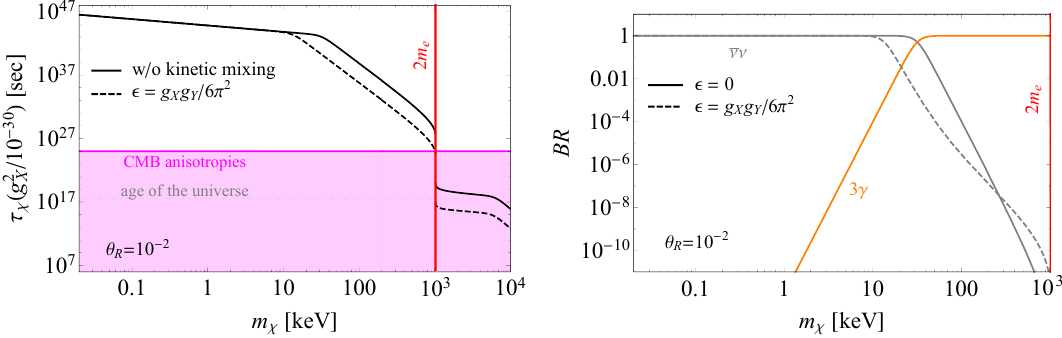
Figure 1 . Lifetime (left) and BRs (right) of decaying VDM as function of the VDM mass m χ , for m E = 1 TeV and θ R = 10 − 2 . Solid (dashed) lines assumes zero kinetic mixing ( (cid:15) = g X g Y / (6 π 2 ) ). Note that τ χ ∝ g − 2 and that all BRs are independent of g X , as well as θ R in the absence of kinetic X mixing. The dot-dashed line denotes the present age of the Universe and the shaded magenta region is excluded by studies of CMB anisotropies. The vertical red line denotes the electron-positron threshold m χ = 2 m e